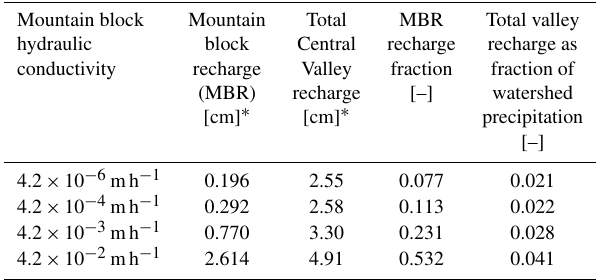
Table 1. Sensitivity of mountain block recharge in the San Joaquin Basin to Sierra Nevada block hydraulic